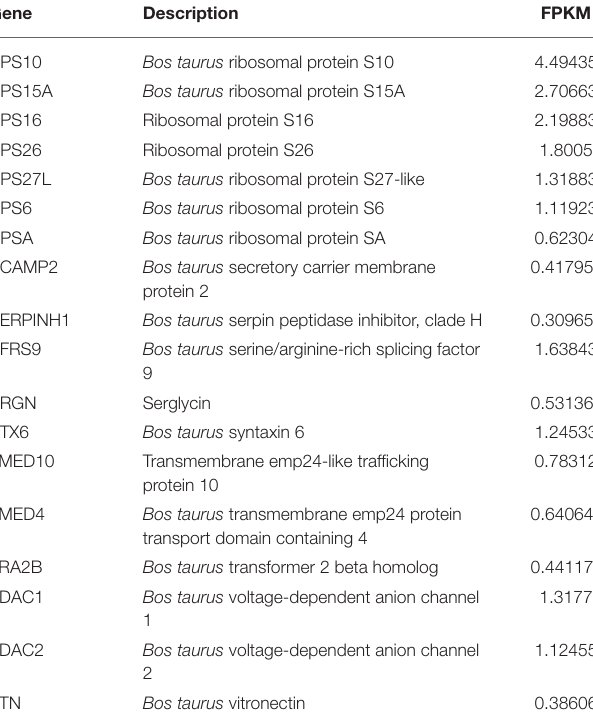
TABLE 4 | Transcripts encoding ffEV proteins that were detected in bovine